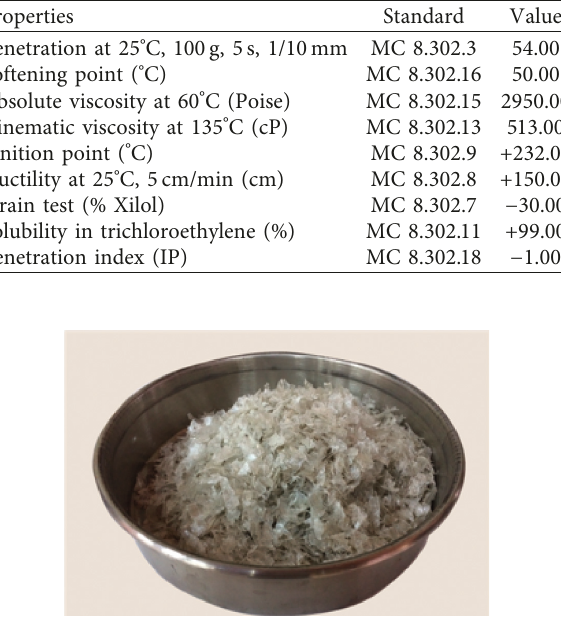
Figure 2: PET particles used on asphalt mixtures. Table 2: PET particles according to ASTM